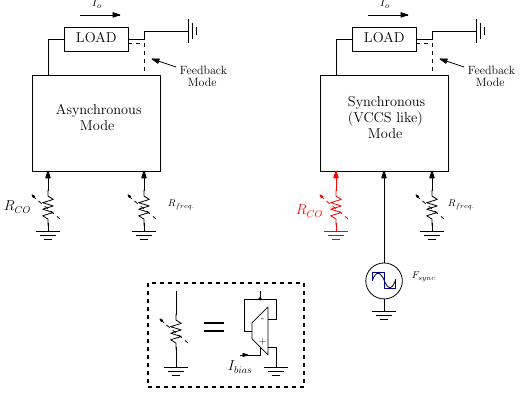
Figure 6. Oscillator operation